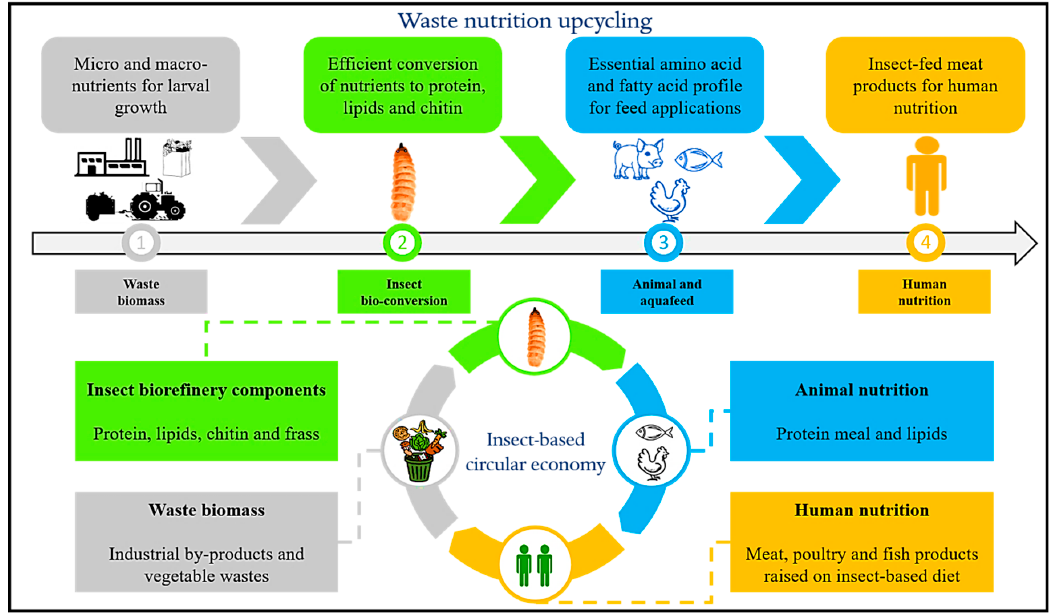
Figure 4. Nutrition upcycling from waste streams and circular economy.